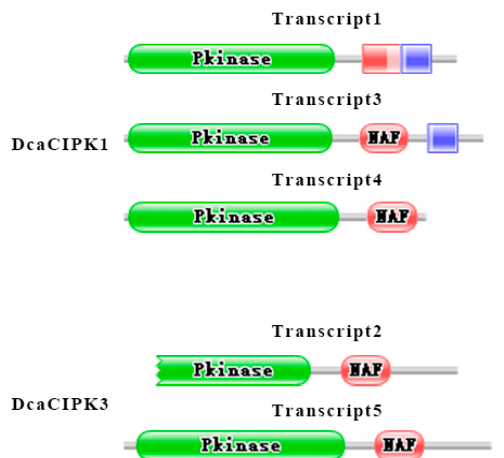
Figure 7. Analysis of the protein domains in main expressed transcripts of DcaCIPK 1/3. Green boxes represent pkinase domain. Red boxes represent NAF domain. Blue boxes represent KA1 domain. Grey lines represent amino acid